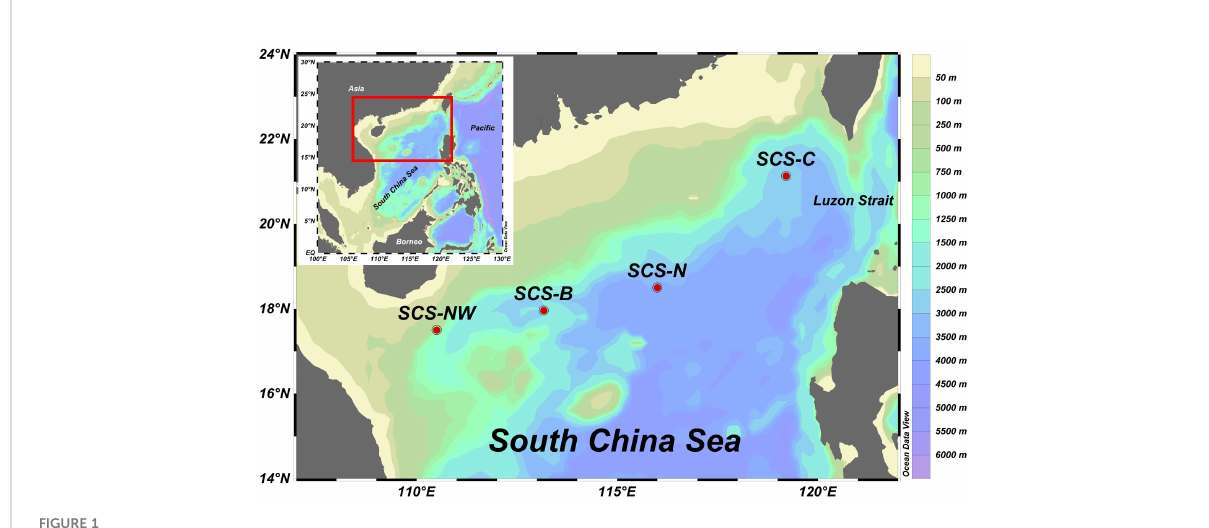
FIGURE 1 Site locations of the sediment trap moorings in the